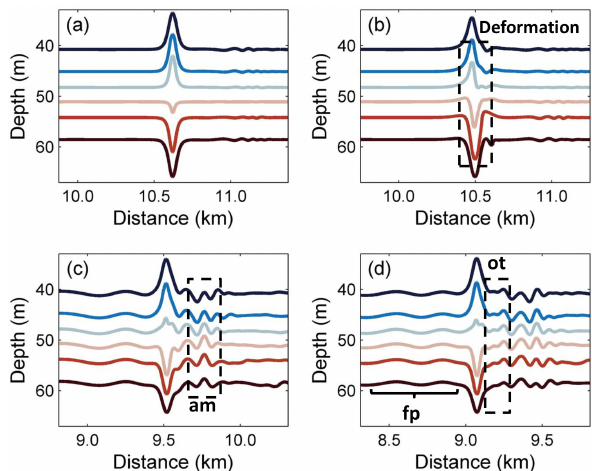
Figure 7. The evolution processes of the mode-2 ISW in case O9 ( (cid:49) = 2 . 0) for the different times (a) 0 T , (b) 1.2 T , (c) 10 T , and (d) 14 T , where “am”, “fp” and “ot” denote the amplitude-modulated wave packet, forward-propagating long wave and oscillating tail, respectively.